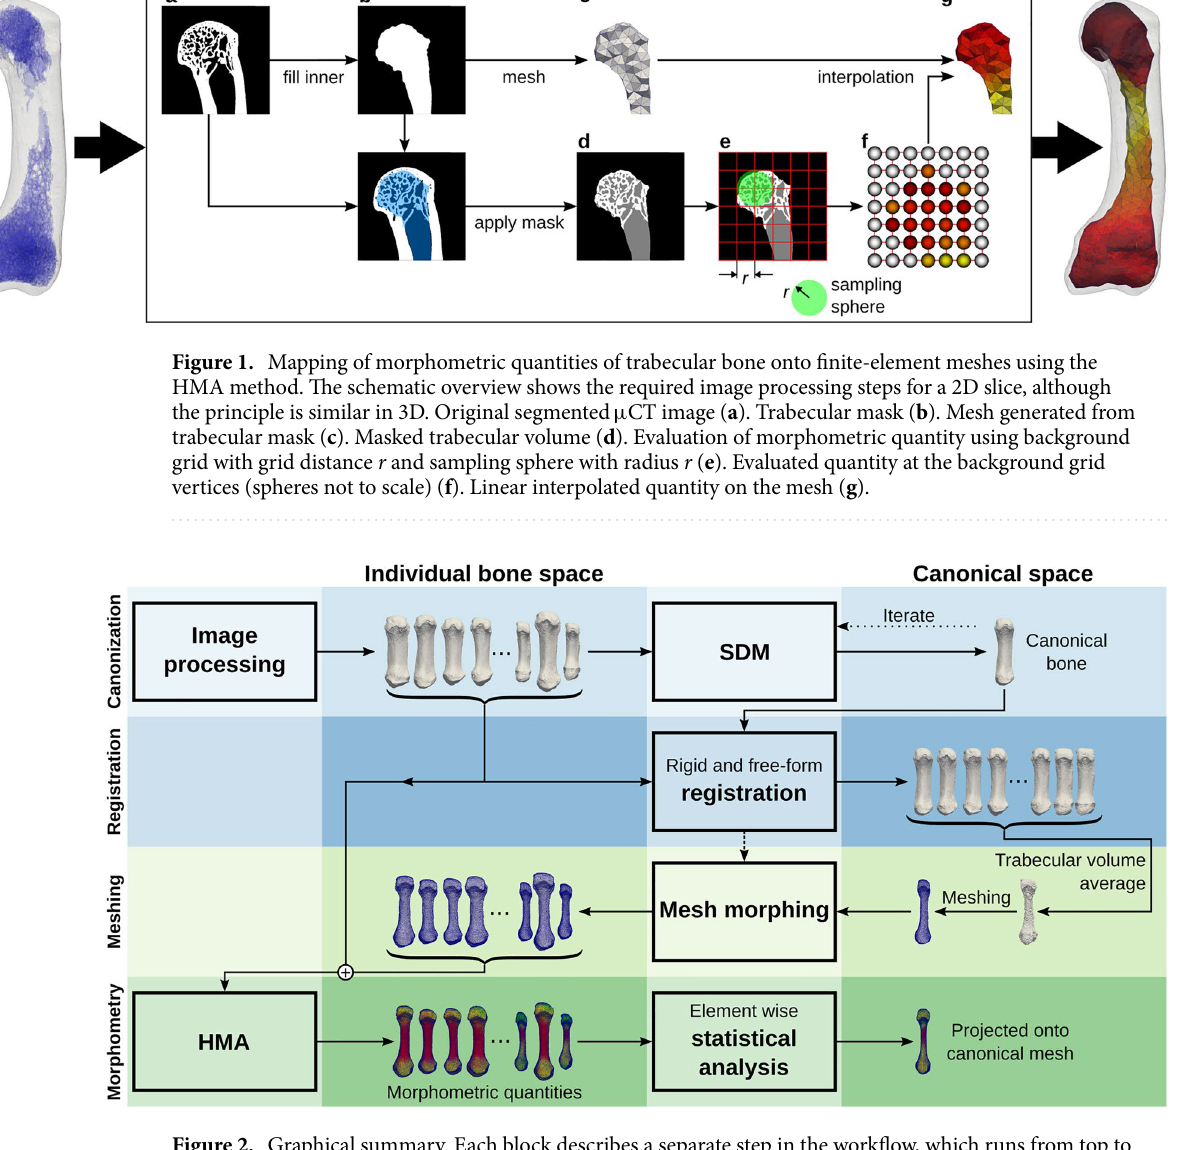
dividual bone space. The HMA method can then be applied using the original bone images and these individual meshes, which possess homologous elements across the sample. In a further step, the mapped morphometric quantities can be statistically compared at each element across the samples. If required, results of HMA or the statistical analysis can be mapped back onto the canonical mesh and evaluated further. Statistical deformation model. The SDM is created similar to Steiner et al. 47 but the process shall be repeated here briefly. The method operates on masked images of bones, where one image (the mask) describes the label of each voxel (bone or background) while the other image contains the actual grey-value. These can be the same images as required for the HMA workflow. All images are registered onto a randomly chosen reference image using a similarity transform. This type of transform allows only for translation, rotation and isotropic scaling. All similarity transformations are averaged by taking the arithmetic mean of the translation and scaling as well as averaging the rotation by quaternion averaging 48 . The centre of rotation is fixed in all transformations. The inverse of the averaged transformation is then applied to the reference image, to scale, rotate and translate the reference image into an average position. In the next step all images are registered onto the aligned reference image. First, a similarity transform is again used, then a free-form deformation is applied using a cubic B-spline transformation. Such a B-spline transformation is parametrized using a so called control point grid, which is deformed to create the overall image transformation. When all images are registered, the transformed images